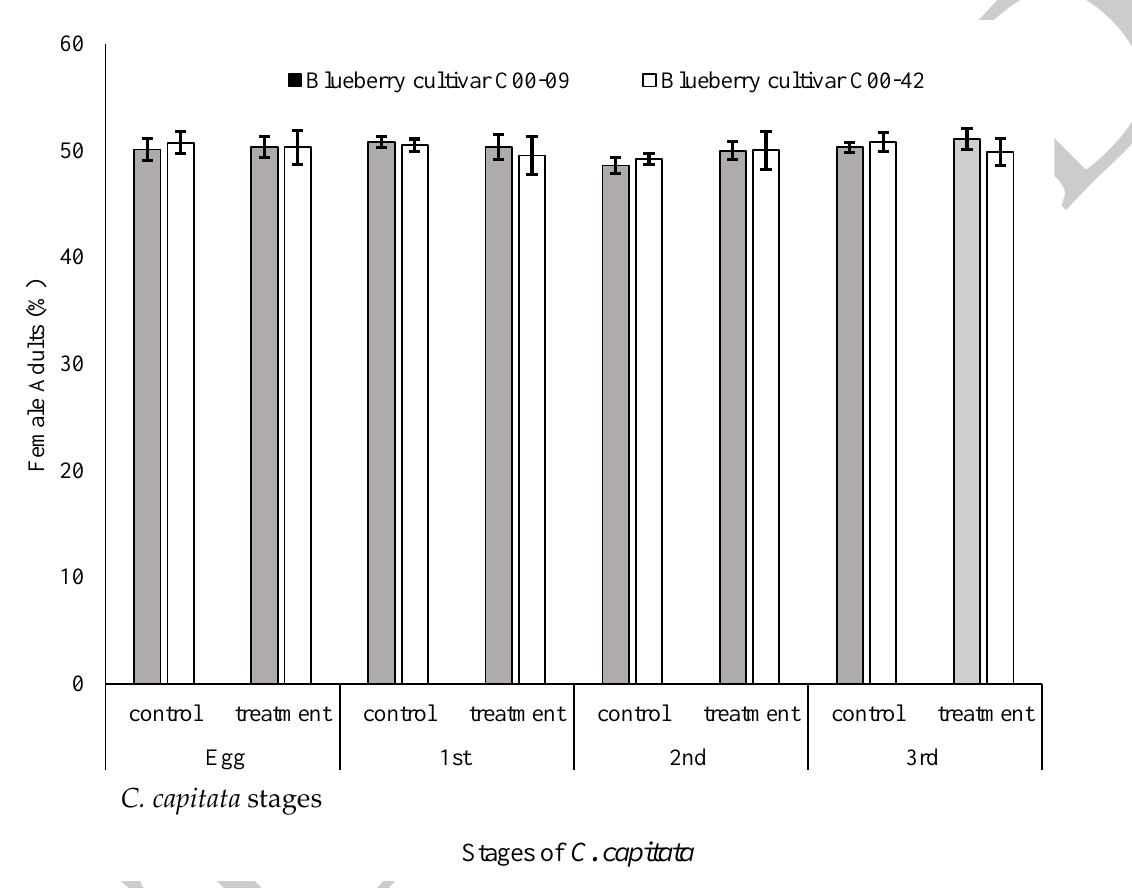
Figure 1. The average female adult ratios of survived adults for each stage in blueberry cultivar C00-09 and C99-42 after cold treatment. Error bar means standard error. An ANOVA single factor test was used to compare sex ratios, p > 0.05.